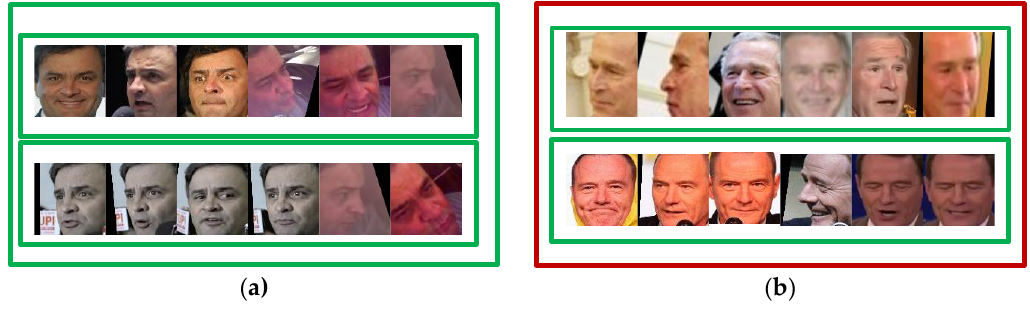
Figure 14. The IARPA Janus Benchmark A (IJB-A) dataset face verification (1:1) test protocol. ( a ) Face verification for the same objects. ( b ) Face verification for different objects.